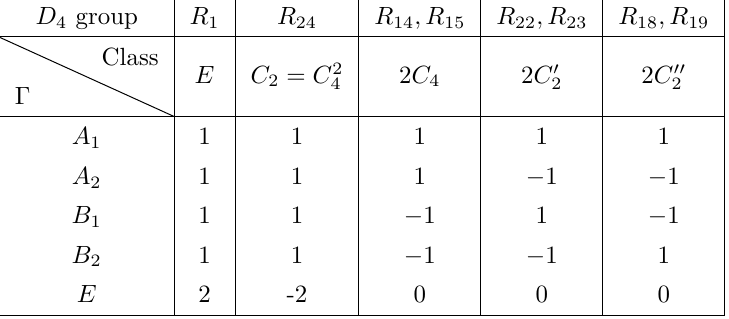
Table 8 . Character table for the D 4 group. The group elements R i are listed in table 5.